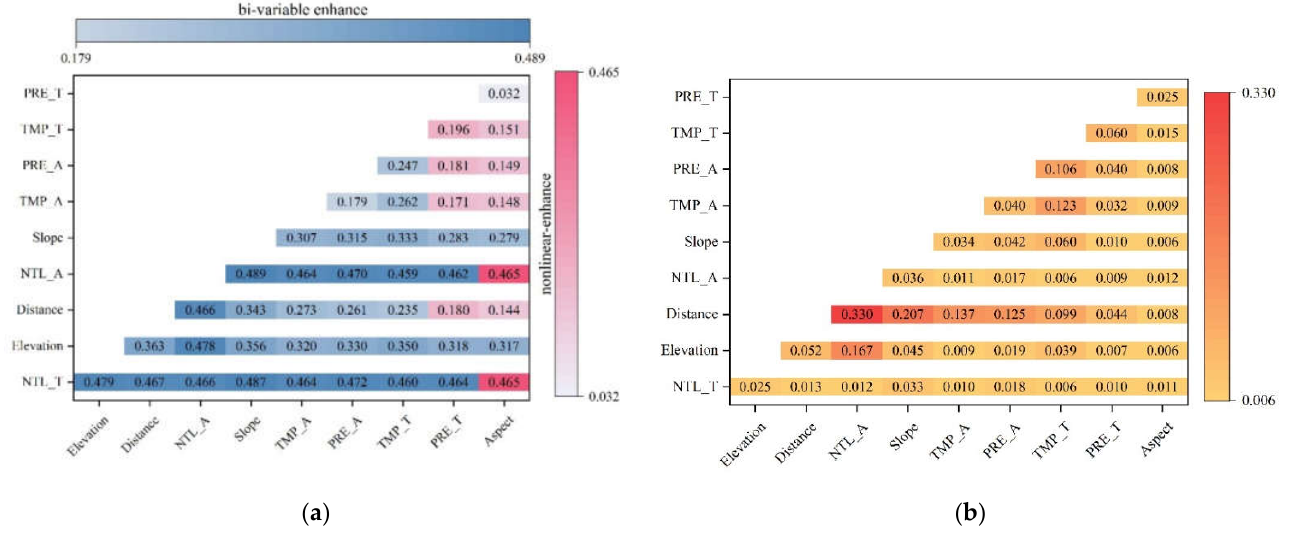
Figure 6. The interaction of factors on vegetation changes and the difference of q value between interactions and individuals. ( a ) The interaction of factors consisted of bi-variable enhance and nonlinear-enhance; ( b ) The difference of q value of each factor between their interactions and indi- viduals. For example, 0.33 is the difference of q value between the interaction of distance to road (Distance) and annual average nighttime light (NTL_A) (q = 0.466) and the independent effect of Distance (q =